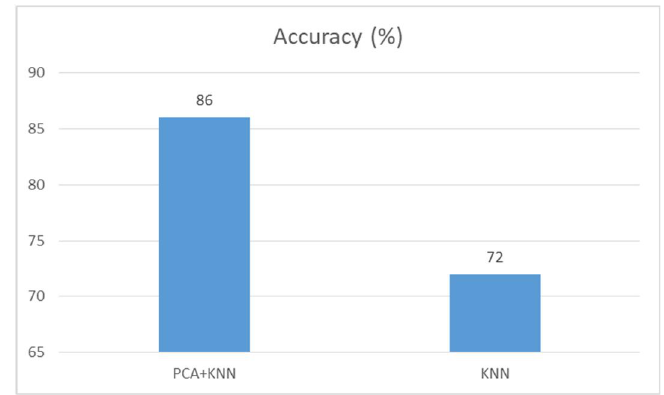
Fig. 4 The result of system